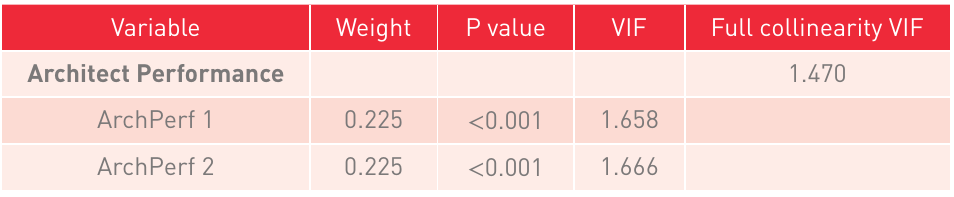
Assessment of the measurement model for formative